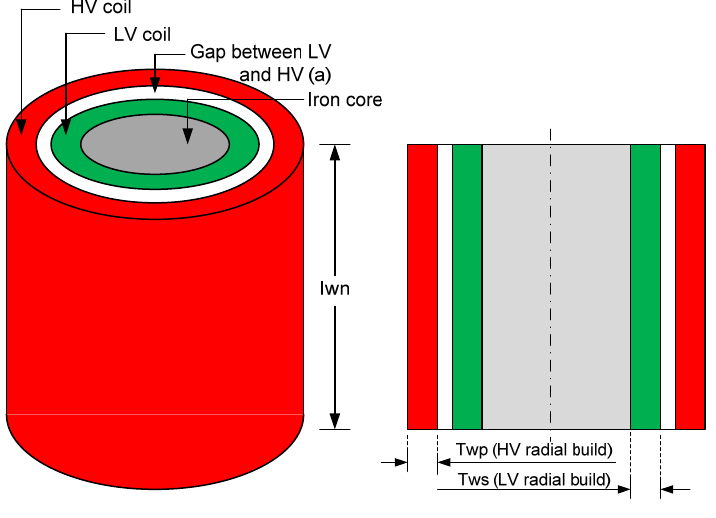
Figure 1. The space of winding transformer.